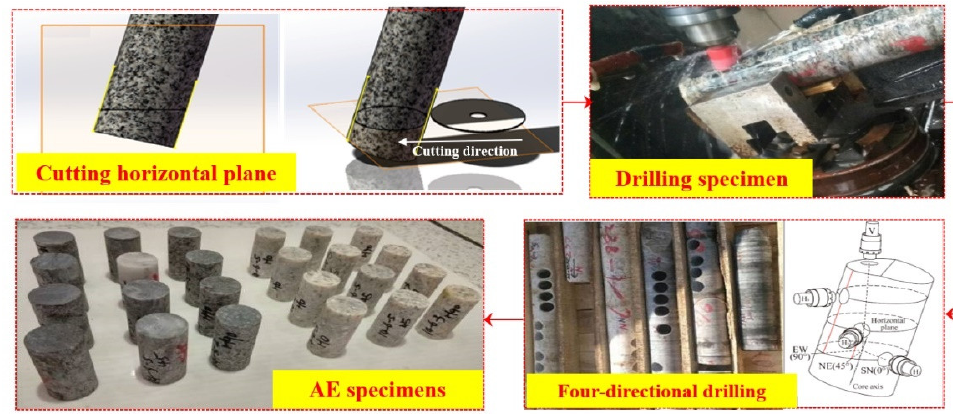
Figure 6. Schematic representation of the drilling of cylindrical specimens.